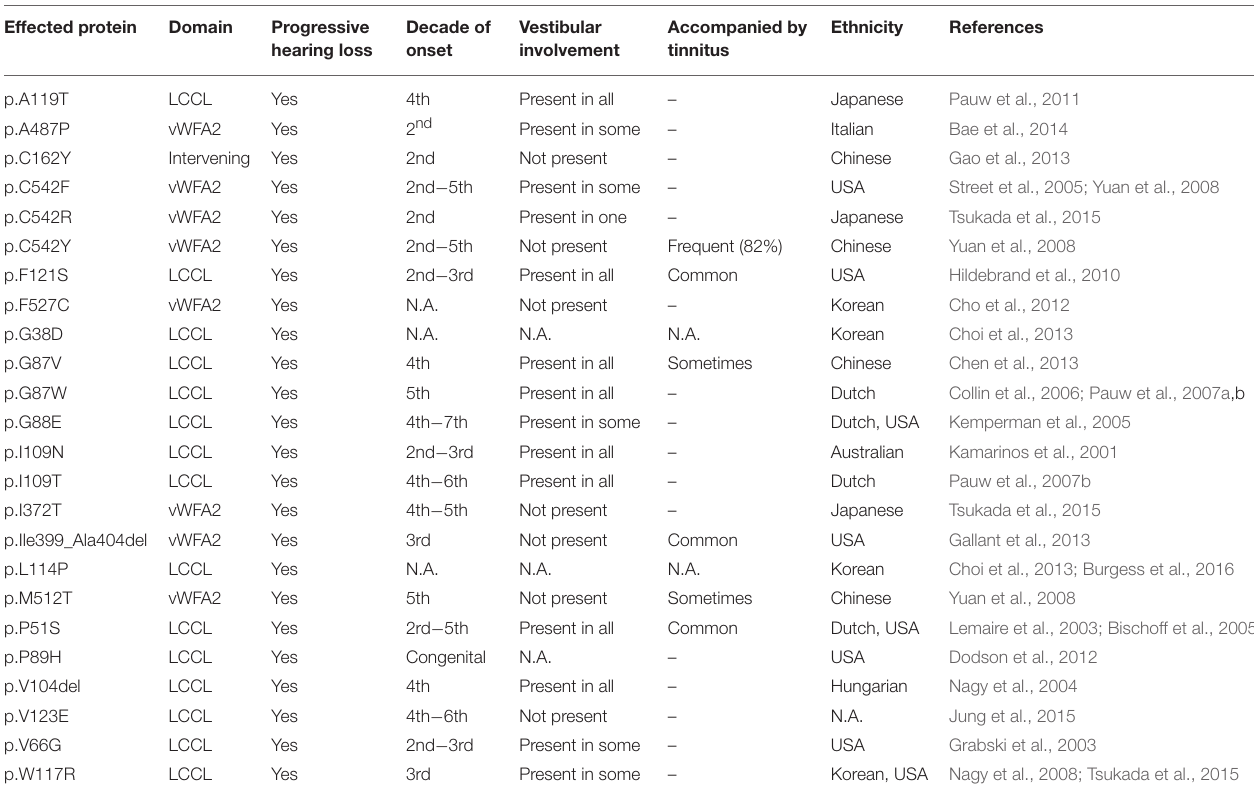
TABLE 1 | Known COCH mutations and clinical